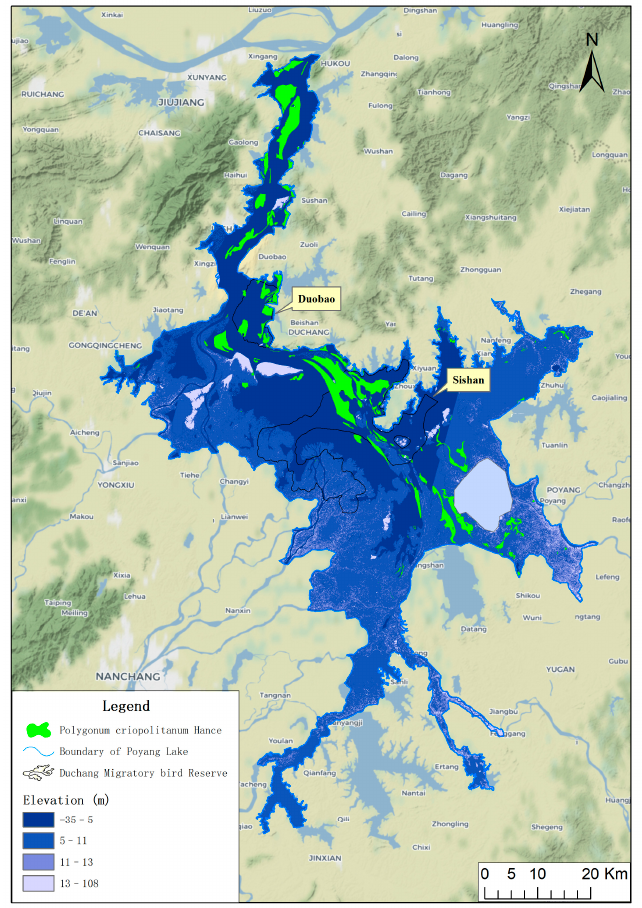
Figure 5. Spatial distribution characteristics of Polygonum criopolitanum in Poyang Lake wetland.